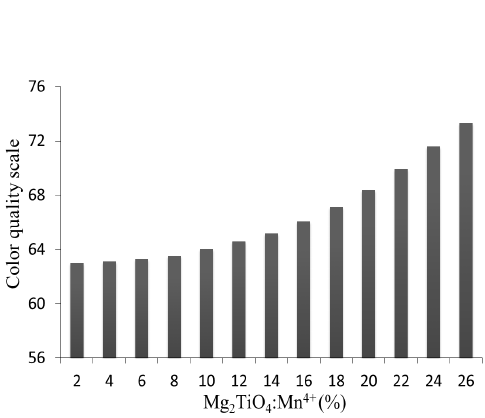
This is an important feature in apply- ing Mg TiO 4 :Mn 4+ , especially when manag- 2 ing color quality is more di(cid:30)cult with WLEDs at high temperatures.